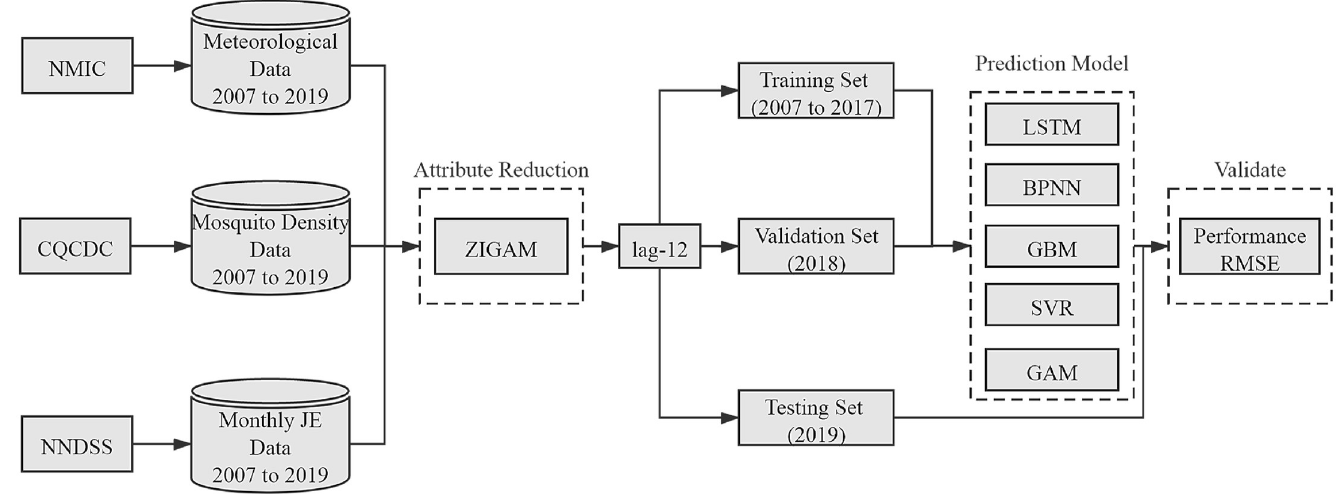
Fig 2. Summarized workflow for the construction of the LSTM-based forecasting model for JE cases and its comparison with other candidate models. NMIC: National Meteorological Information Center; CQCDC: Chongqing Center for Disease Control and Prevention; NNDSS: National Notifiable Disease Surveillance System; BPNN: Back Propagation Neural Network; GBM: Gradient Boosting Machine; SVR: Support Vector Regression; GAM: Generalized Additive Model.